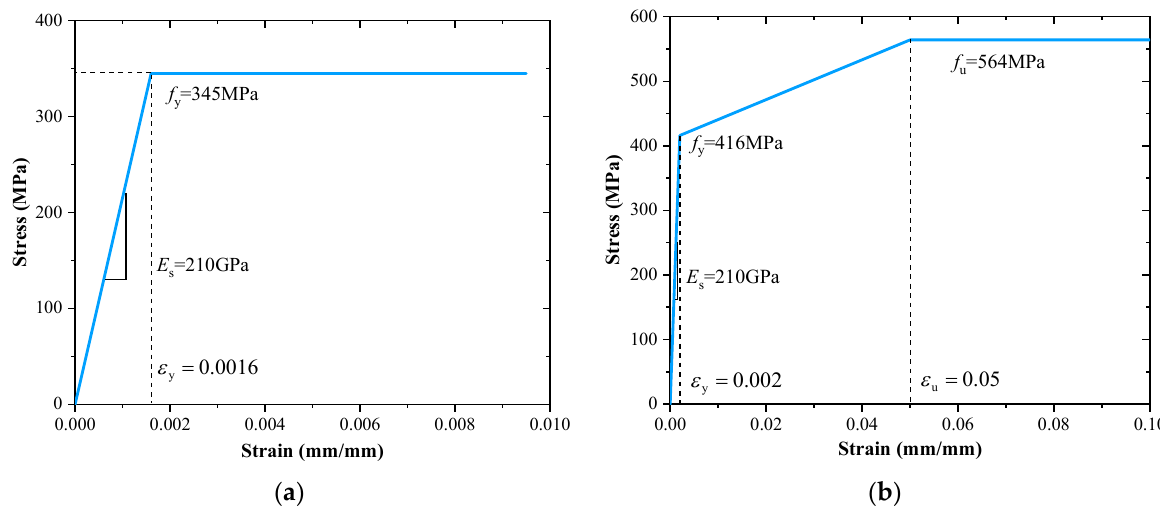
Figure 5. Constitutive relationship of steel: ( a ) stress–strain curve of steel beam; ( b ) stress–strain curve of reinforcement.